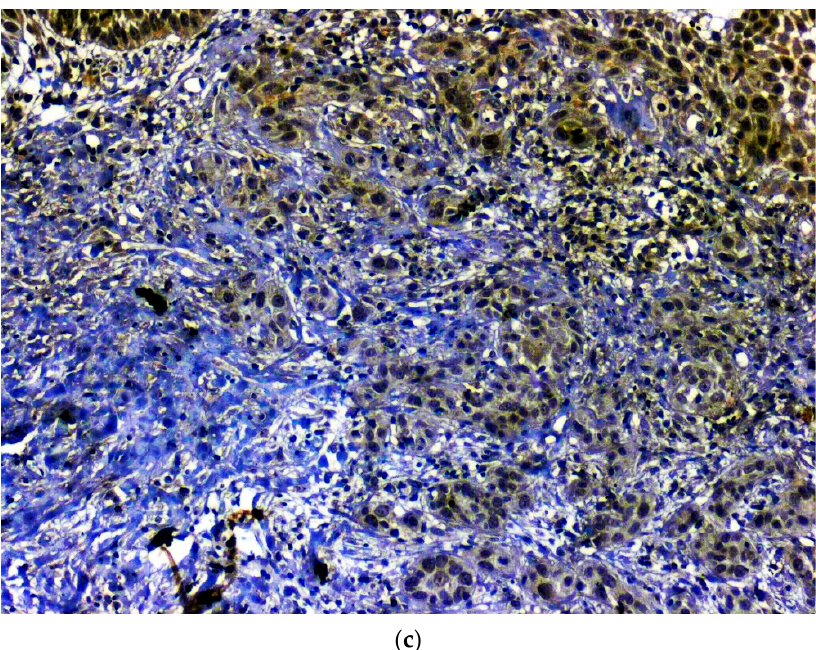
Figure 1. ( a ) IHC for OCT 3/4 in healthy control hyperplastic oral epithelium, showing negative stain, ( b ) IHC for OCT 3/4 in oral submucous fibrosis showing intense nuclear positivity, and ( c ) IHC for OCT 3/4 in MDSCC showing intense nuclear positivity (under 20 × magnification). Table 2. Clinicopathological features of OCT 3/4 expression in OSMF, OSCC and healthy controls. Table 3. Clinicopathological features of SOX 2 expression in OSMF, OSCC and healthy